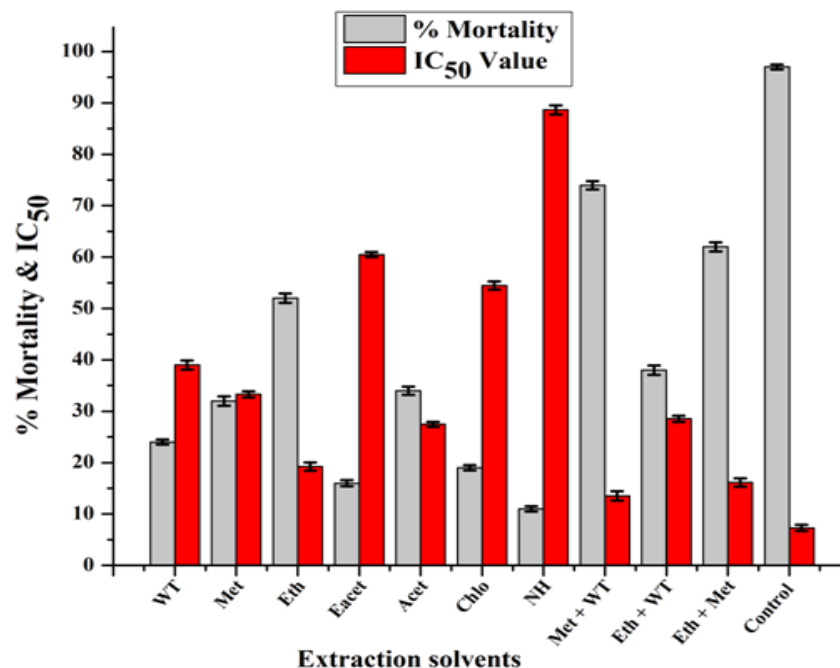
FIGURE 9 - Cytotoxic effects and IC of different solvent extracts of E . intermedia on HepG2 liver cancer cell lines. 50 Data is represented as mean ± standard error of three separate experiments. WT: water, Met: methanol, Eth: ethanol, Eacet: ethyl acetate, Acet: acetone, Chlo: chloroform, NH: n-Hexane, Met + WT; methanol + water, Eth + WT; ethanol + water, Met + Eth; methanol + ethanol, Slandered drug was